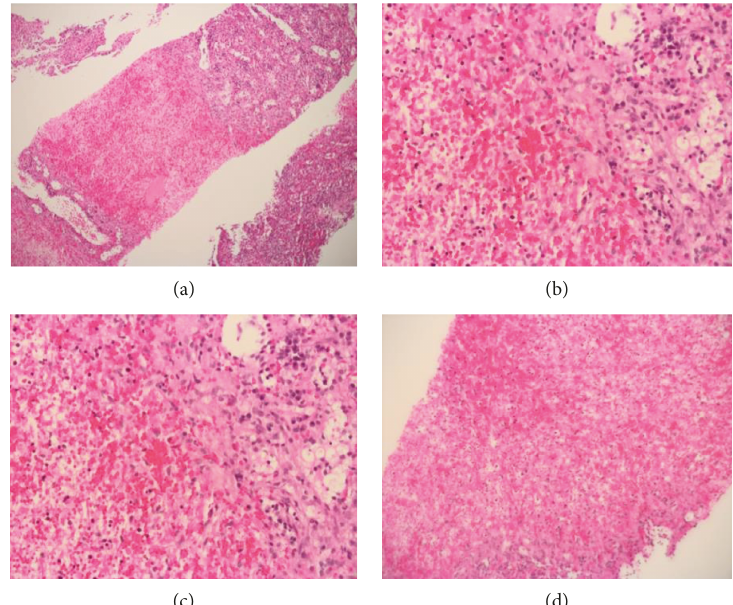
Figure 3: Splenic tissue with focal hemorrhagic infarction necrosis and predominantly neutrophil polymorphs. (a – d) H/E-stained